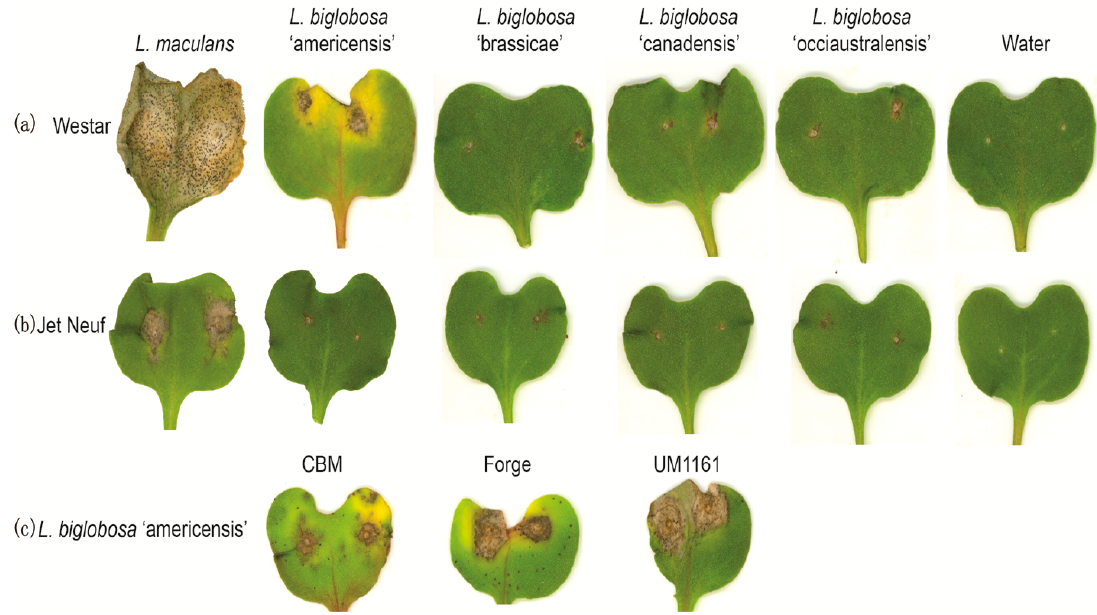
Figure 4. Disease symptoms on cotyledons of Brassica napus cvs Westar ( a ) and Jet Neuf ( b ) 14 days’ post inoculation (dpi) with isolates of L. maculans (06LM), Leptosphaeria biglobosa ‘americensis’ (isolate Phl004), L. biglobosa ‘brassicae’ (LL1-PG1), L. biglobosa ‘canadensis’ (06J37), L. biglobosa ‘occiaustralensis’ (14P207), and water. ( c ) Disease symptoms on cotyledons of Brassica juncea cultivar. Common brown mustard (CBM), B. juncea cv. Forge, and B. rapa line UM1161 14 dpi with L. biglobosa ‘americensis’ (Phl004).